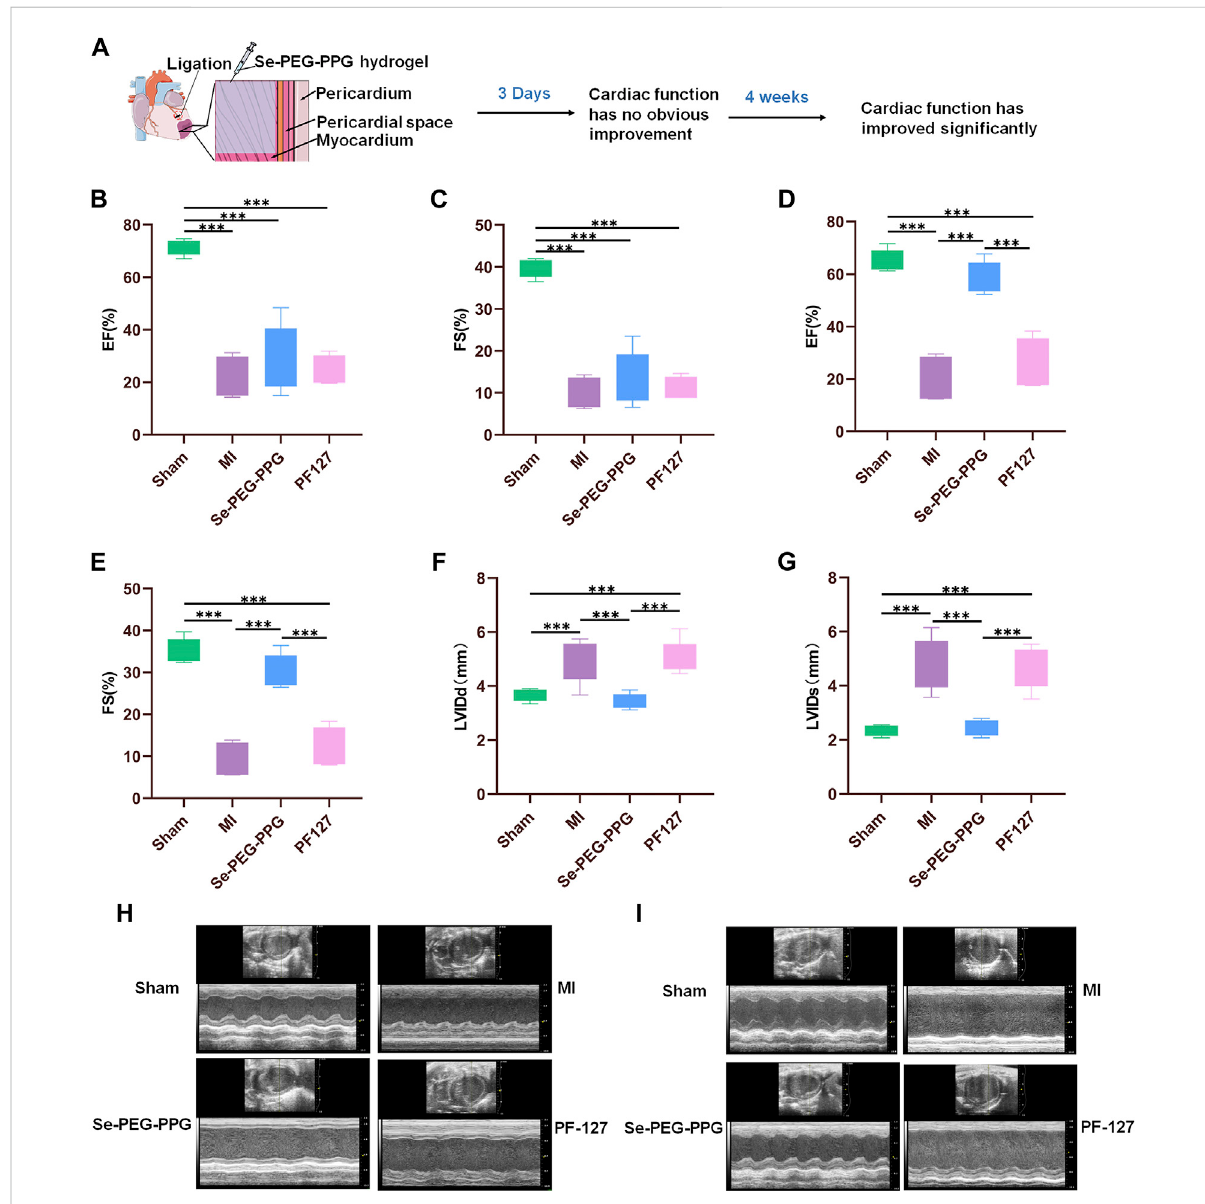
FIGURE 4 The performance of cardiac function post MI. (A) Myocardial function has improved signi fi cantly at28th day post MI; (B,C) Quantitative analysis of left ventricular ejection fraction (EF) and shortened fraction (FS) on the third day after MI ( n = 5, *** p < 0.01); (D,E) Quantitative analysis of left ventricular ejection fraction (EF) and shortened fraction (FS) at 28th day post MI ( n = 5, *** p < 0.01); (F,G) Quantitative analysis of left ventricular diastolic inner diameter (LVIDd) and left ventricular systolic inner diameter (LVIDS) at 28th day post MI ( n = 5, *** p < 0.01); (H) Representative echocardiographic images on the third day after MI; (I) Representative echocardiographic images at 28th day post